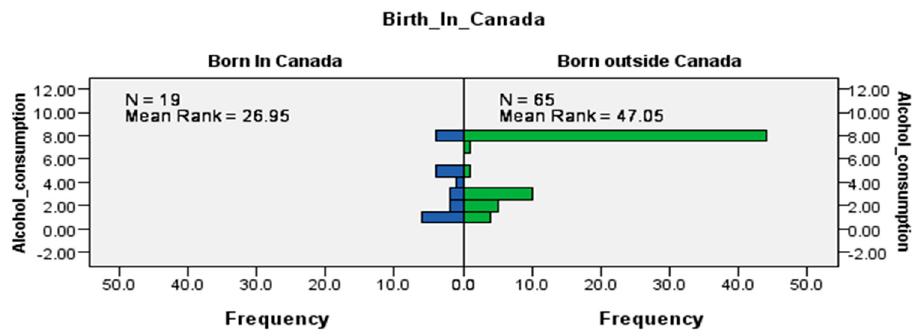
Figure 4. Independent-samples Mann–Whitney U test of the distribution of alcohol consumption across immigrant status.